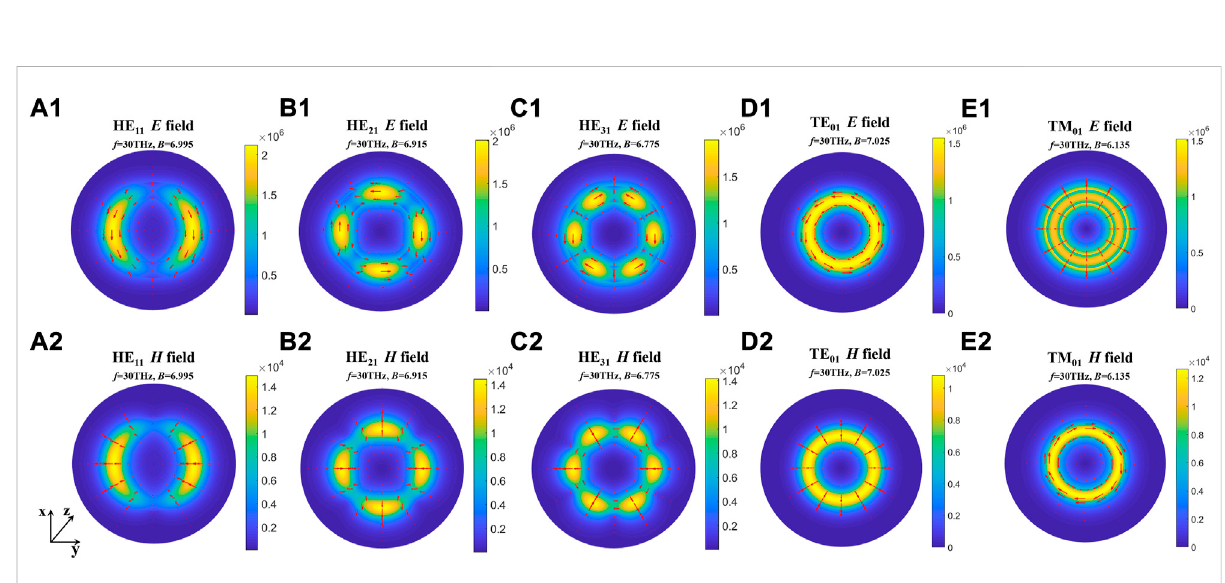
FIGURE 5 The lateral fi eld distributions of different modes. (A1-E1) Electric fi eld intensities and their vector diagrams of the fi rst fi ve modes; (A2-E2) magnetic fi eld intensities and their vector diagrams of the fi rst fi ve